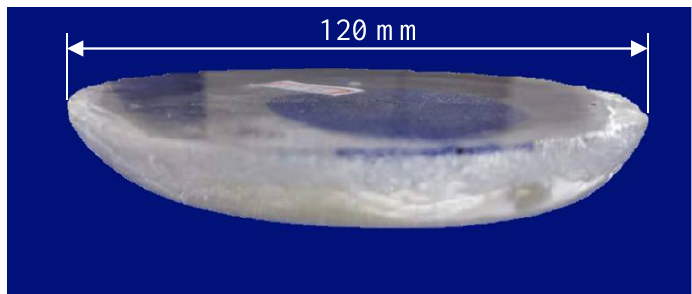
Figure 5. The lateral shape of a melted ice sample.